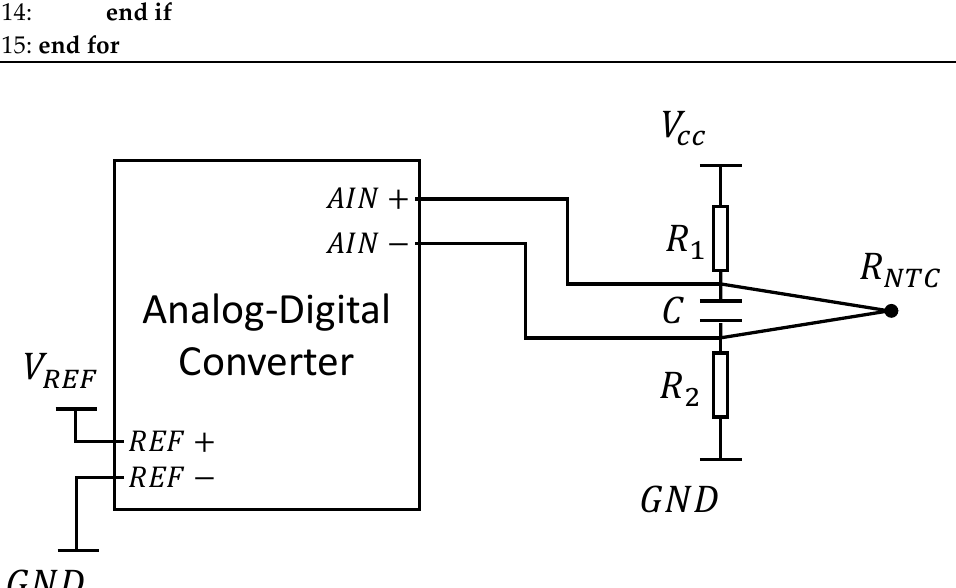
Figure 4. Thermistor temperature measurement principle. Ideally, the resolution accuracy of the ADC voltage measurement can be expressed as (cid:14) ∆ V = V 2 p ( p is the number of ADC bits). Combined with the NTC resistor cc